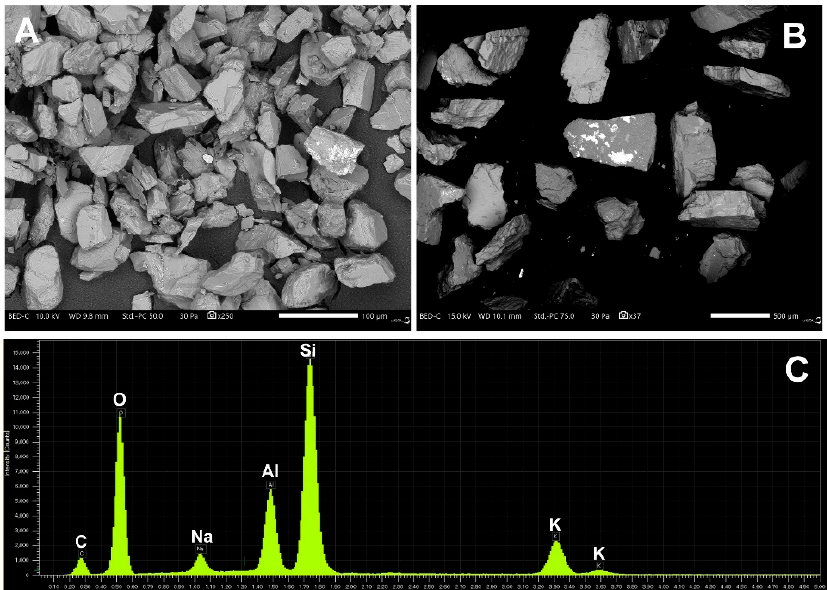
Figure 5. ( A ) Microcline particles smaller than 71 μ m, (B) Microcline particles in the range from 71 μ m up to 315 μ m, (C) Chemical composition of microcline particles determined by EDS. up to 315 µ m, ( C ) Chemical composition of microcline particles determined by EDS.